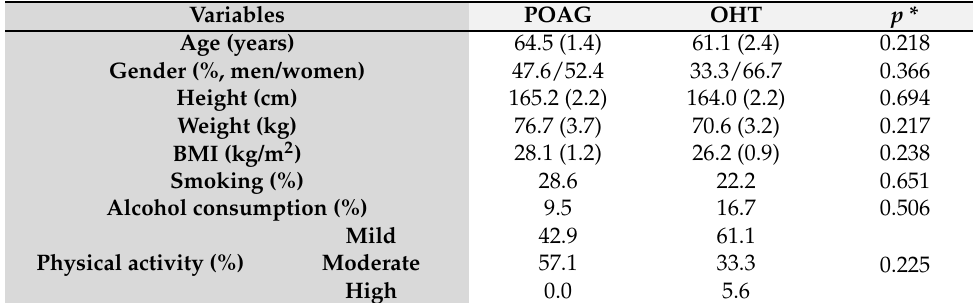
Table 2. Sociodemographic characteristics of the study participants.